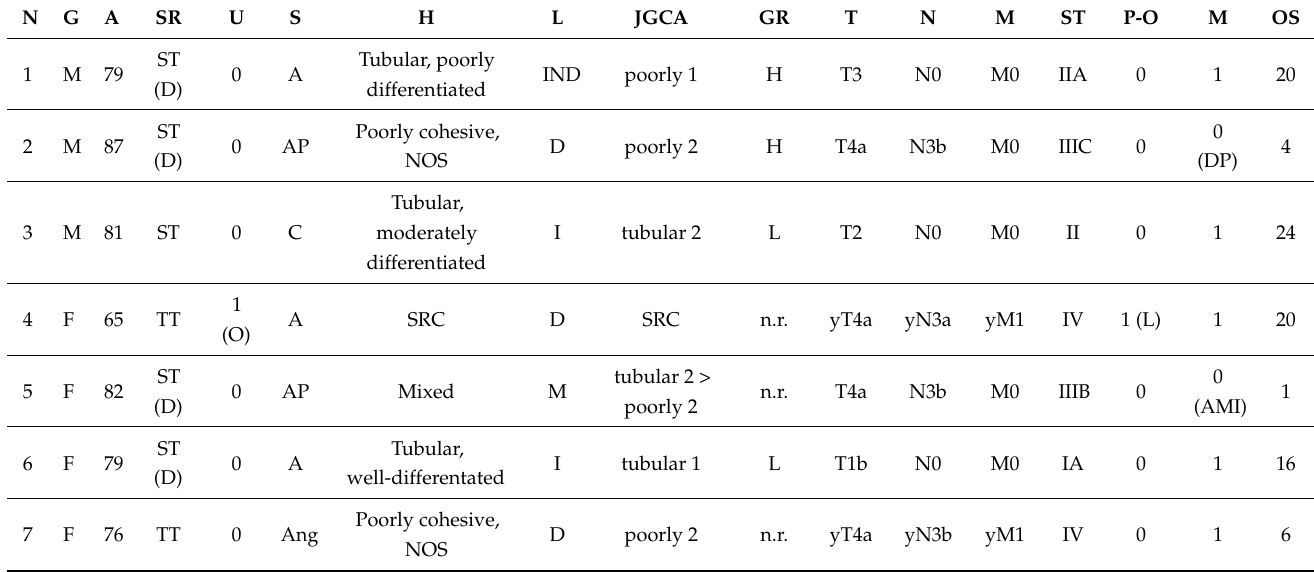
Table 1. Clinicopathological features, morbidity and mortality of study group